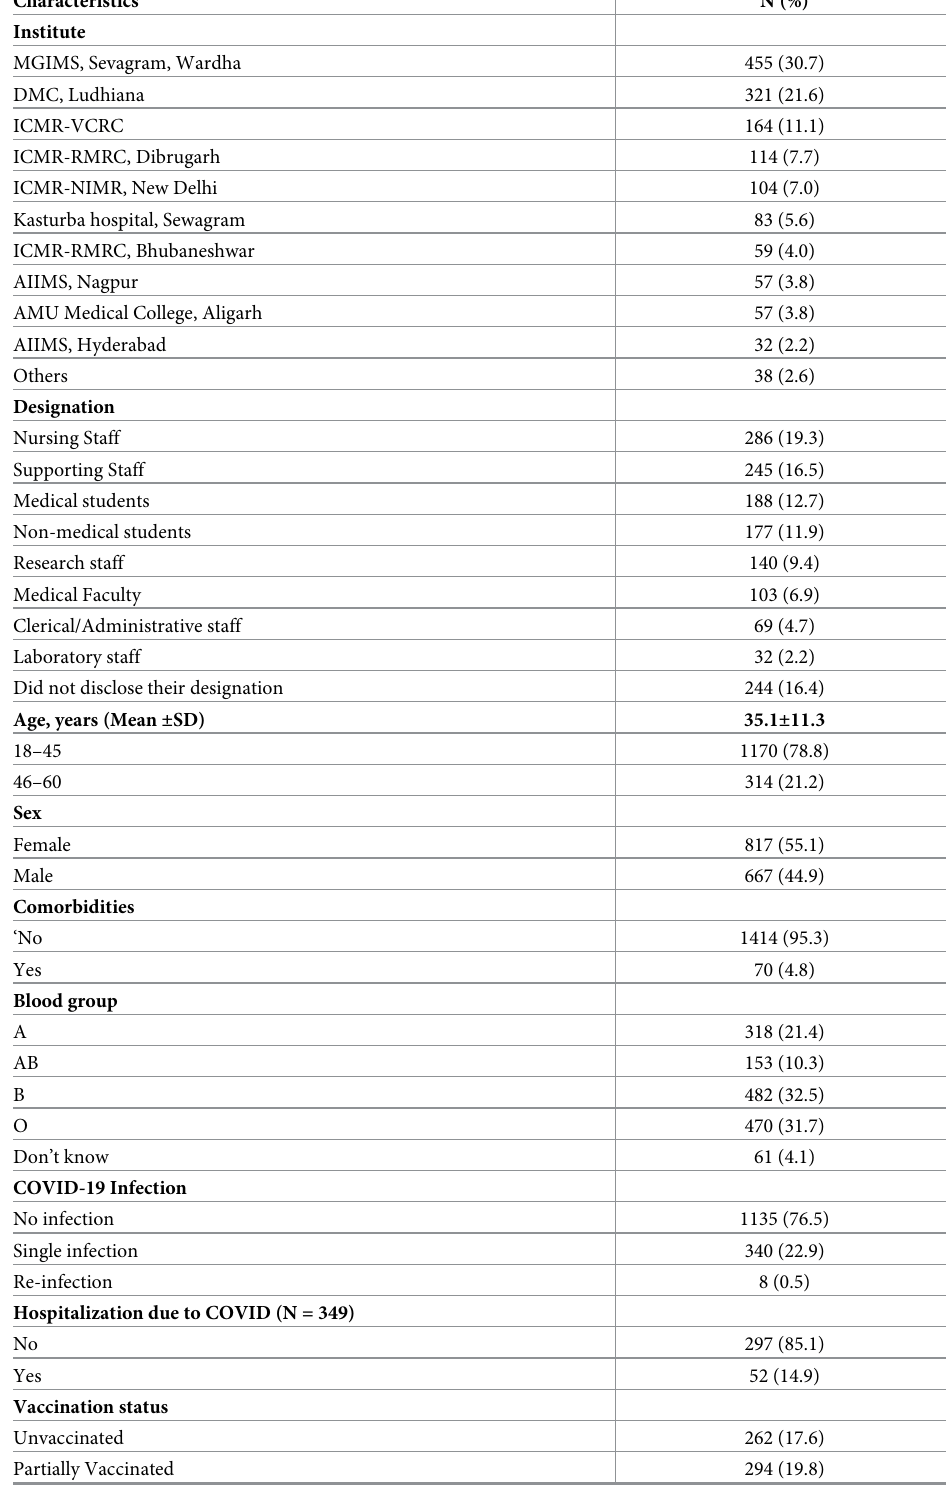
Table 1. Distribution and characteristics of participants (N = 1484).